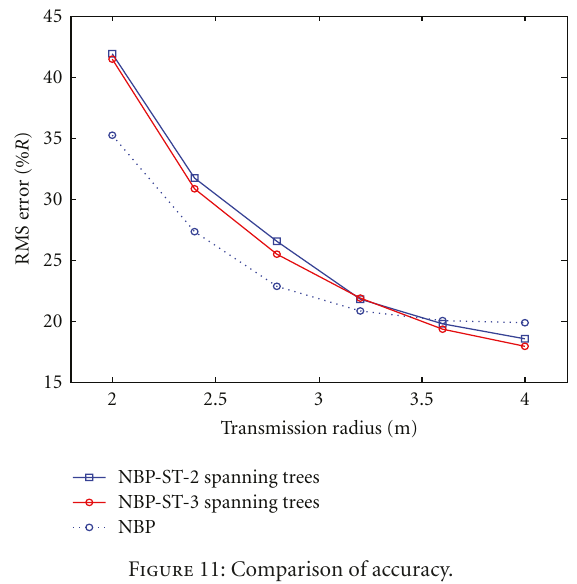
Figure 11: Comparison of accuracy.